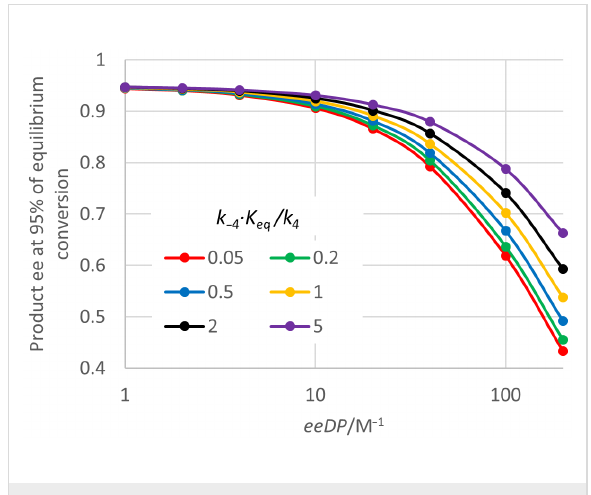
Figure 7: Effect of eeDP and k − 4 · K eq / k 4 on the product ee at high conversion for “ping-pong, first” kinetics. S 0 = 0.2 M, K eq = 15 M, E = 39, k 4 = 1000 s − 1 , SCRf / b = 5, k 2R / k 4 = 1, k 2R / E · k 2S = 1, k 3 · [H 2 O]/ k 4 = 1, k − 1R / k − 3 = 1, E · k − 1S / k − 3 = 1. For this plot, different values of eeDP (= 1/( K M · SCRf / b )) were obtained by varying K M , but similar product ee values were found by varying SCRf / b